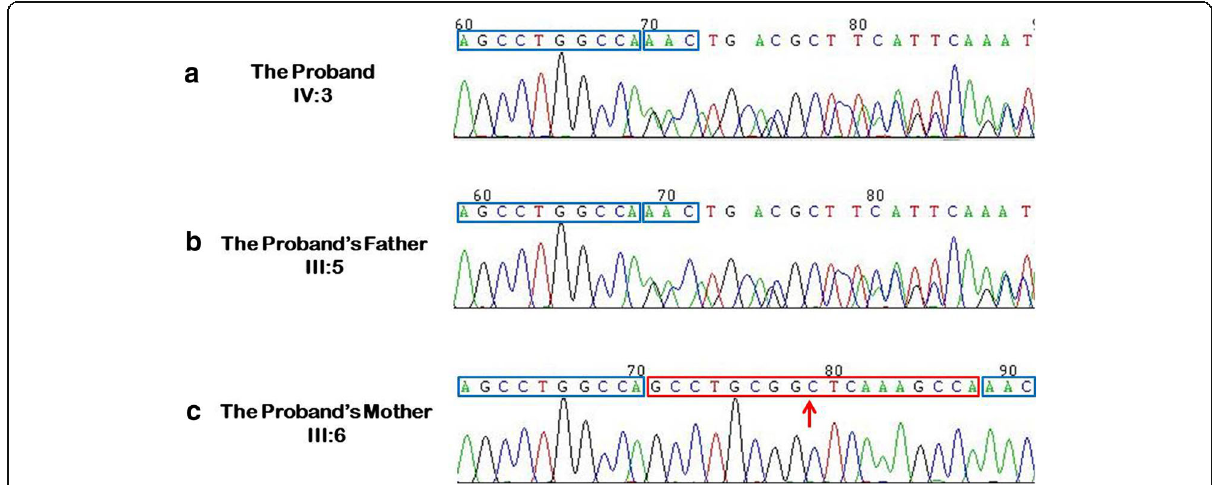
Fig. 3 Sequencing analysis of the PITX3 mutation. Sequence analysis of PITX3 showing an 18 bp deletion in the affected individuals IV:3 ( a ) and III:5 ( b ). The wild-type sequence is shown in c , and the nucleotides deleted in a and b are indicated using a red box and a red arrow